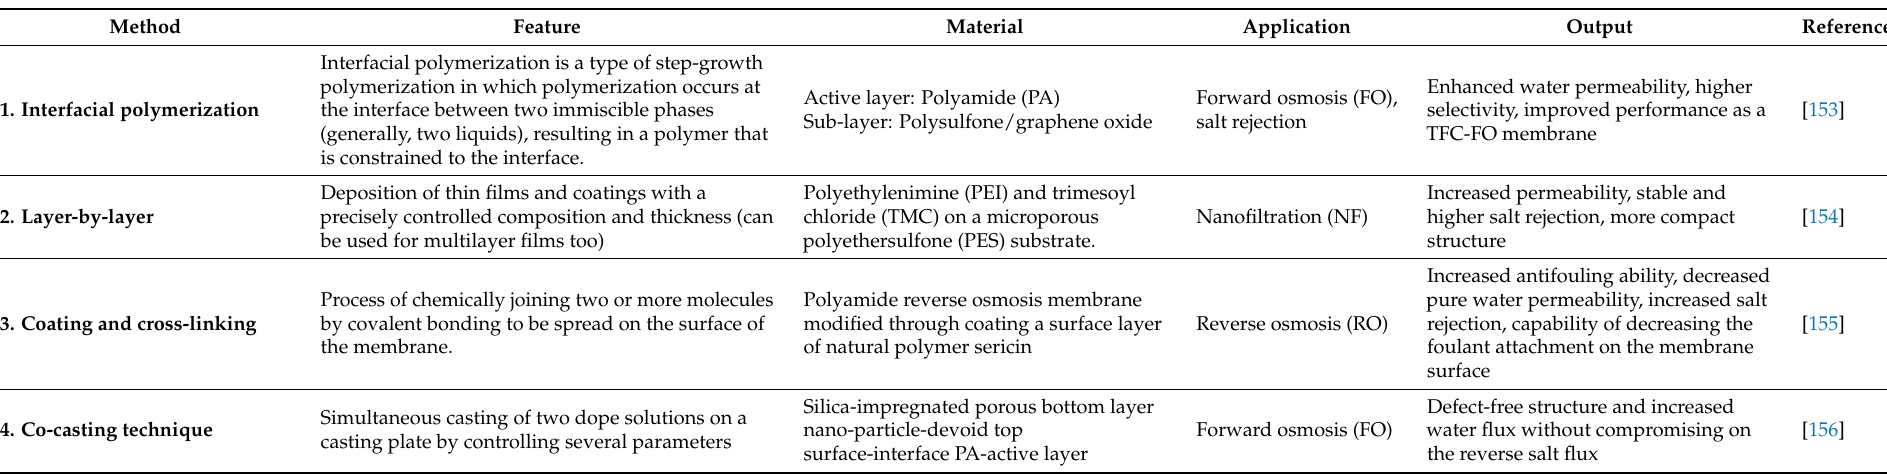
Table 6. Methods of fabricating dual-layered flat sheet membranes.